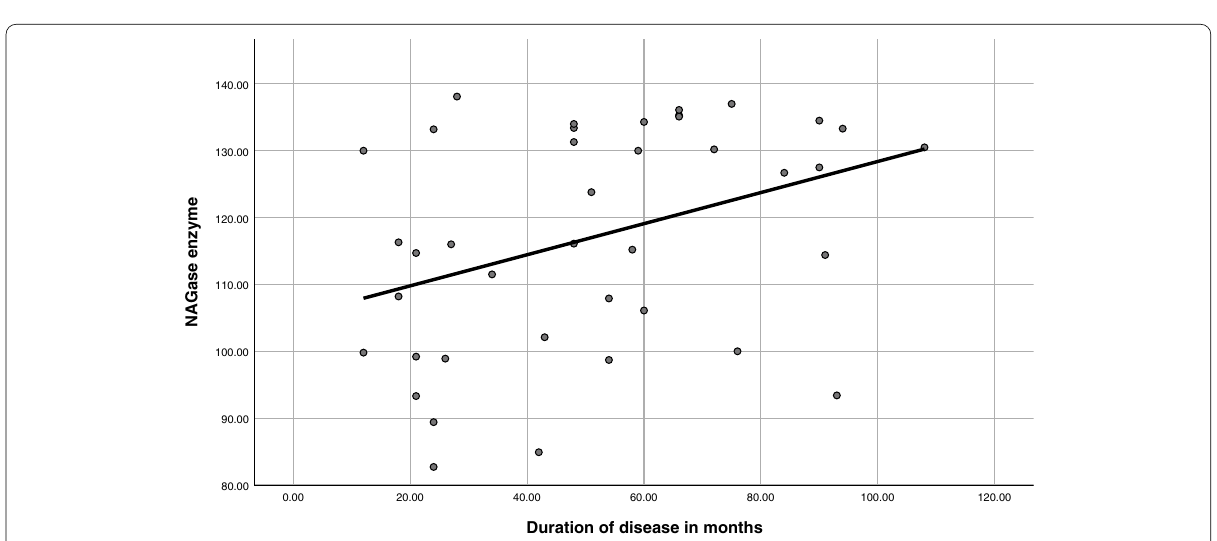
Fig. 2 Correlation between NAG enzyme level and the duration of the disease in cases ( P value